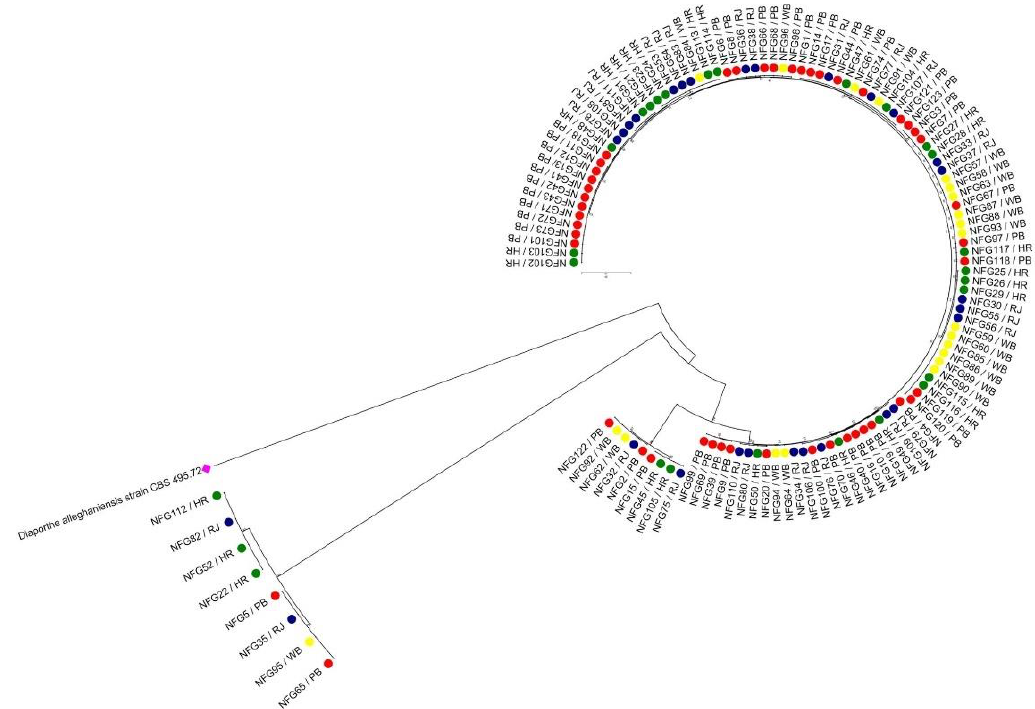
Figure 3. Phylogenetic relationship determined by using combined sequence of three gene loci (TUB, TEF and HIS sequences) and neighbor-joining (NJ) method. The percentage of replicate tree in the bootstrap test is 1000 replicates. The evolutionary distances were computed using the Kimura 2-parameter method. All positions containing gaps and missing data were eliminated. The tree was rooted with Diaporthe alleghaniensis strain CBS 495.72 [KC343733.1].